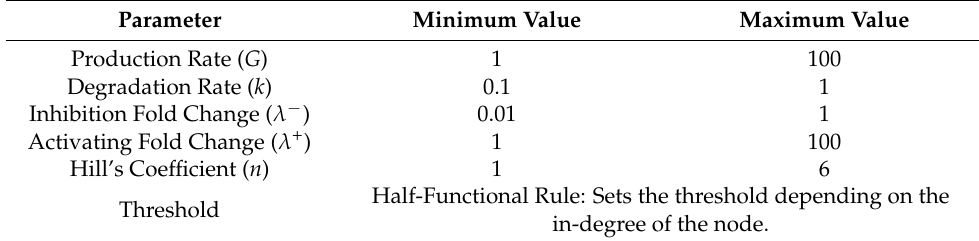
Half-Functional Rule: Sets the threshold depending on the in-degree of the